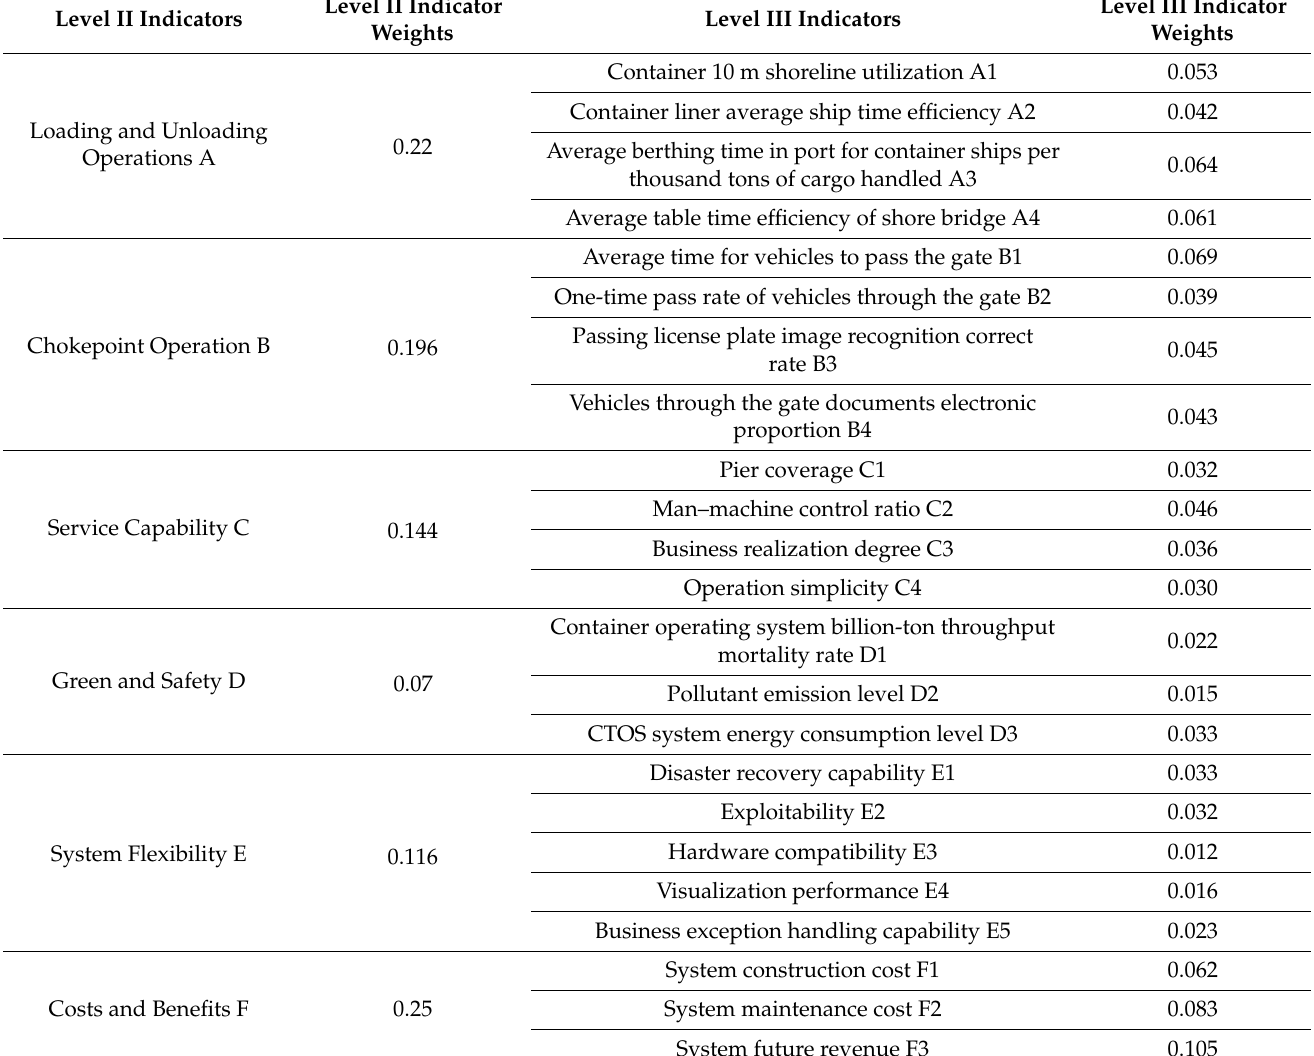
Table 3. CTOS construction performance evaluation index